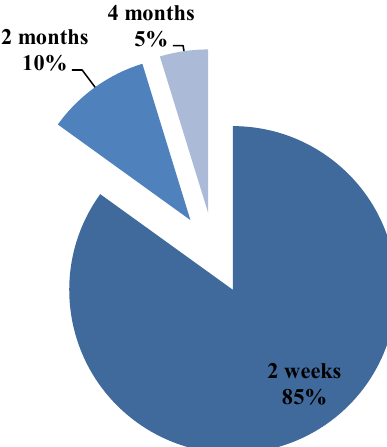
Figure 5. Pie chart of answers related to habits of self-inspection.